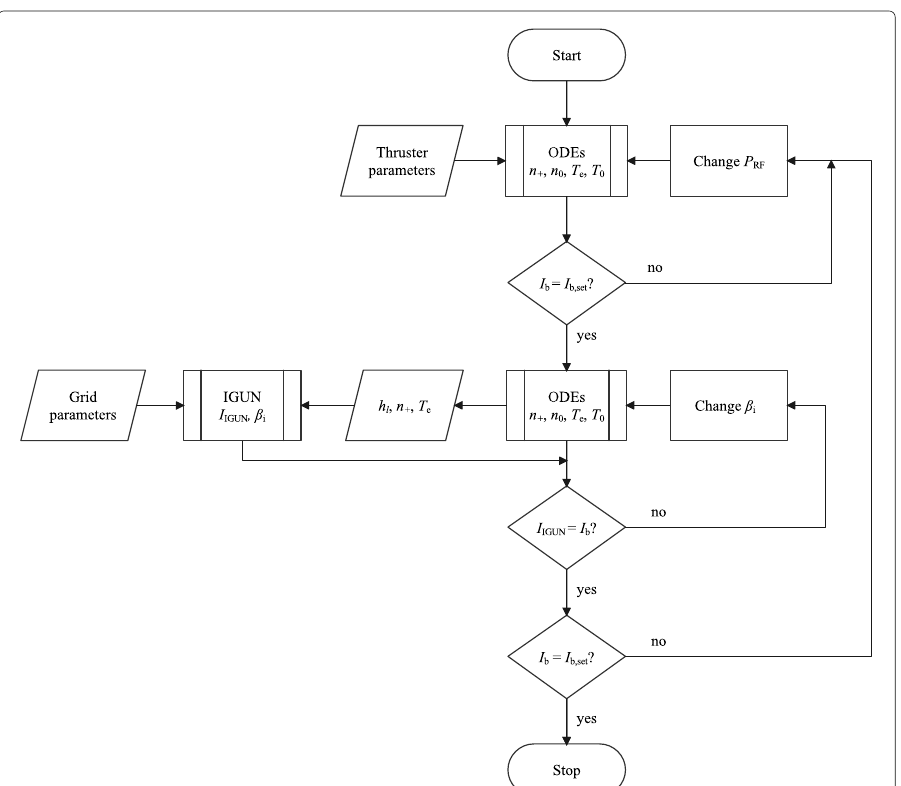
Fig. 2 Flow chart of the global model interacting with IGUN to determine plasma parameters and RF power